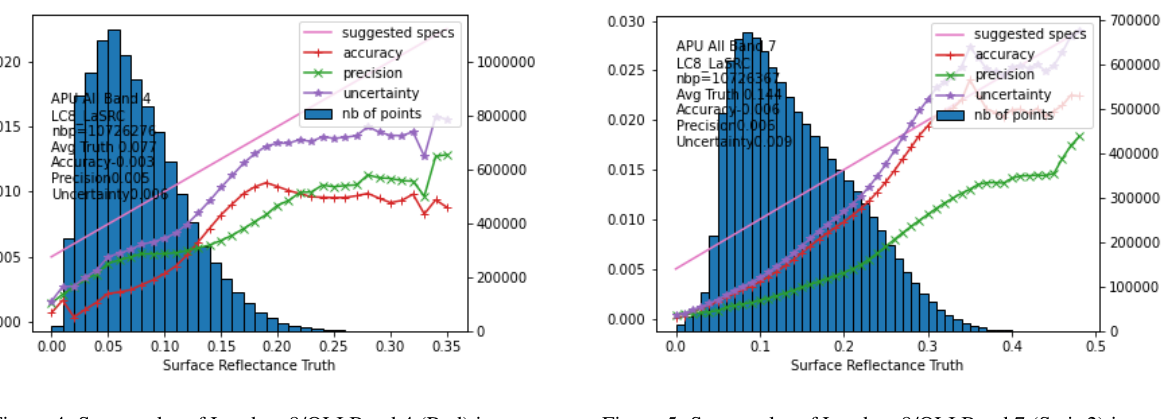
Figure 4. Scatter plot of Landsat-8/OLI Band 4 (Red) image Figure 5. Scatter plot of Landsat-8/OLI Band 7 (Swir 2) image containing accuracy (red line), precision (green line), and containing accuracy (red line), precision (green line), and uncertainty (blue line) as computed in bins (blue bars) where the uncertainty (blue line) as computed in bins (blue bars) where the magenta line represents the theoretical SR reference for Landsat magenta line represents the theoretical SR reference for Landsat SR (0 . 005 + 0 . 05 ˙ ρ ) . SR (0 . 005 + 0 . 05 ˙ ρ ) . 2) and red (Band 4) bands as scatter plots and APU metrics obtained during the